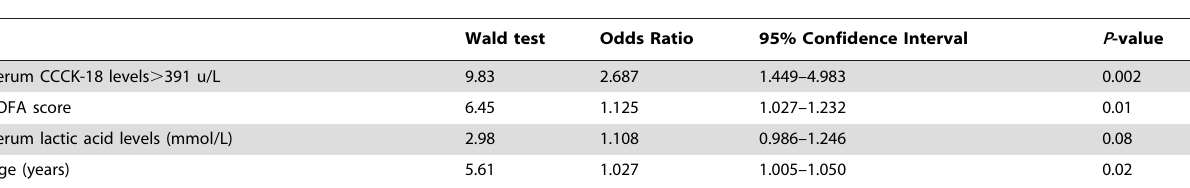
Table 2. Multiple logistic regression analyses to predict survival at 30